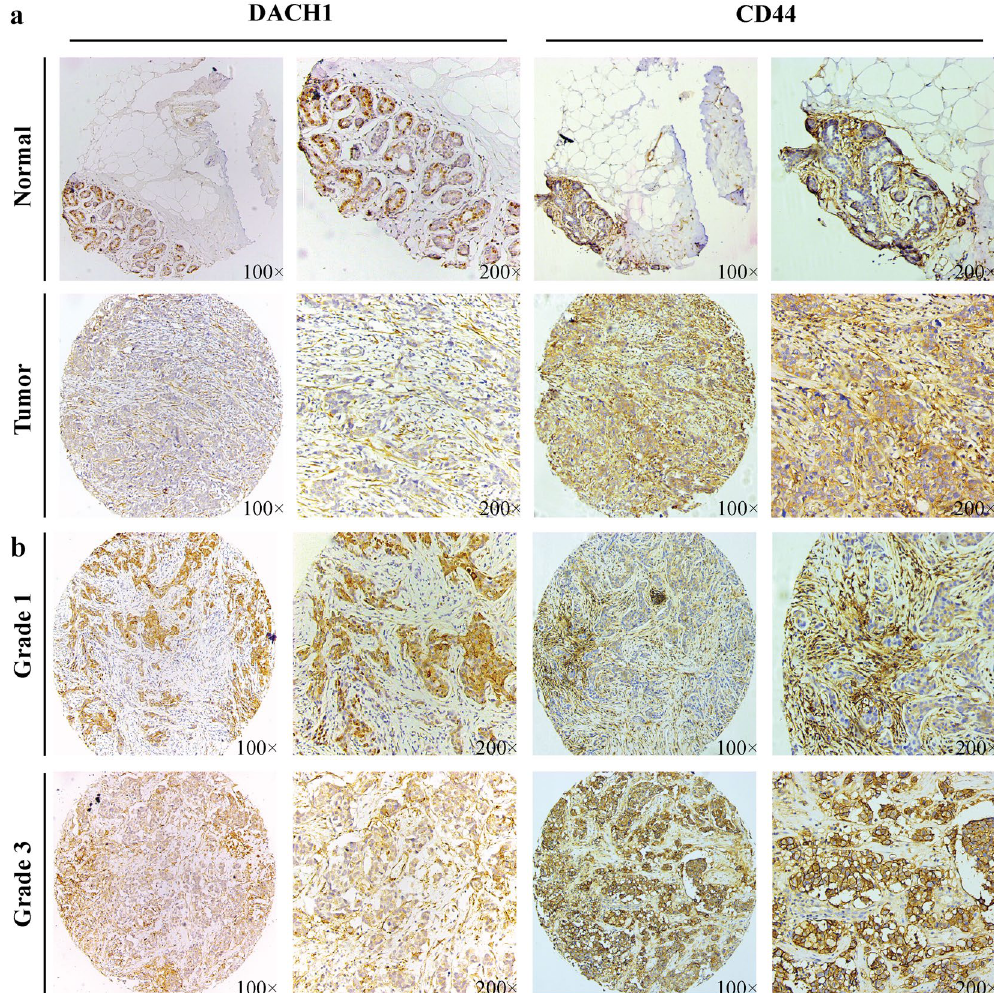
Figure 1. DACH1 and CD44 were correlated with tumorigenesis and histological grade of breast carcinoma. ( a ) Representative images of immunohistochemistry staining of DACH1 and CD44 in noncancerous and cancerous tissues were shown. ( b ) Representative images of immunohistochemistry staining of DACH1 and CD44 in low-grade and high-grade breast neoplasm tissues were